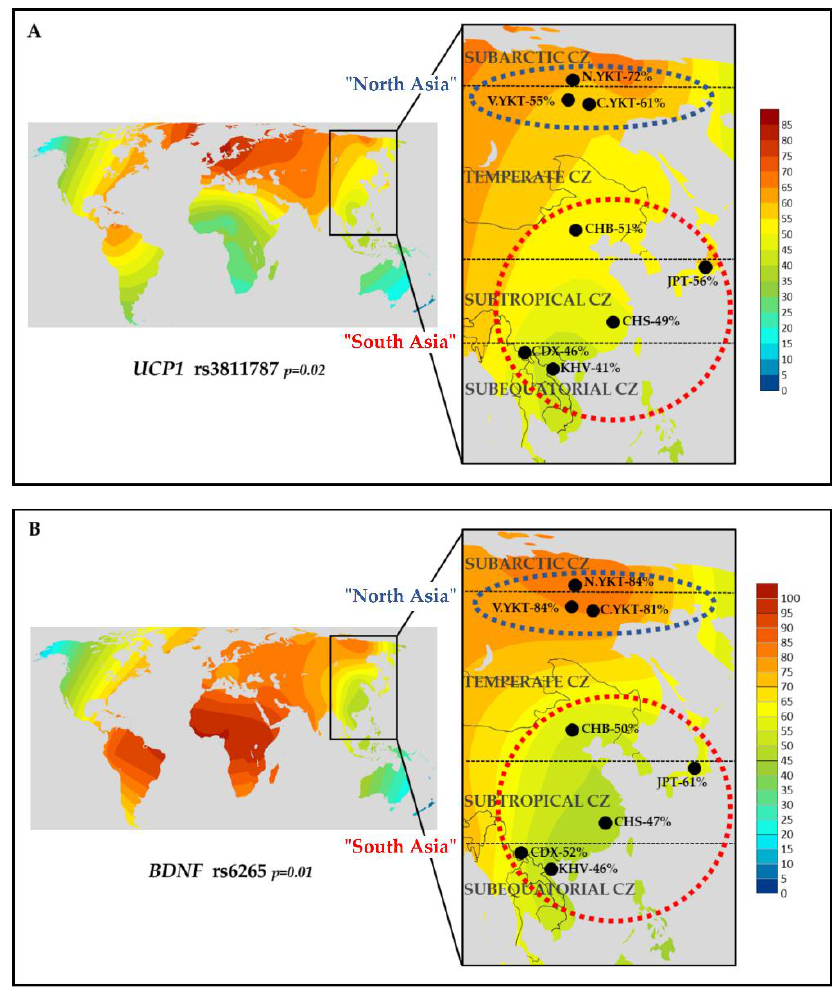
Figure 3. The search for indicators of natural selection for cold climate adaptation. ( A ) T-allele, rs3811787 ( UCP1 ). ( B ) G-allele, rs6265 ( BDNF ). The allele prevalence gradients are indicated on the